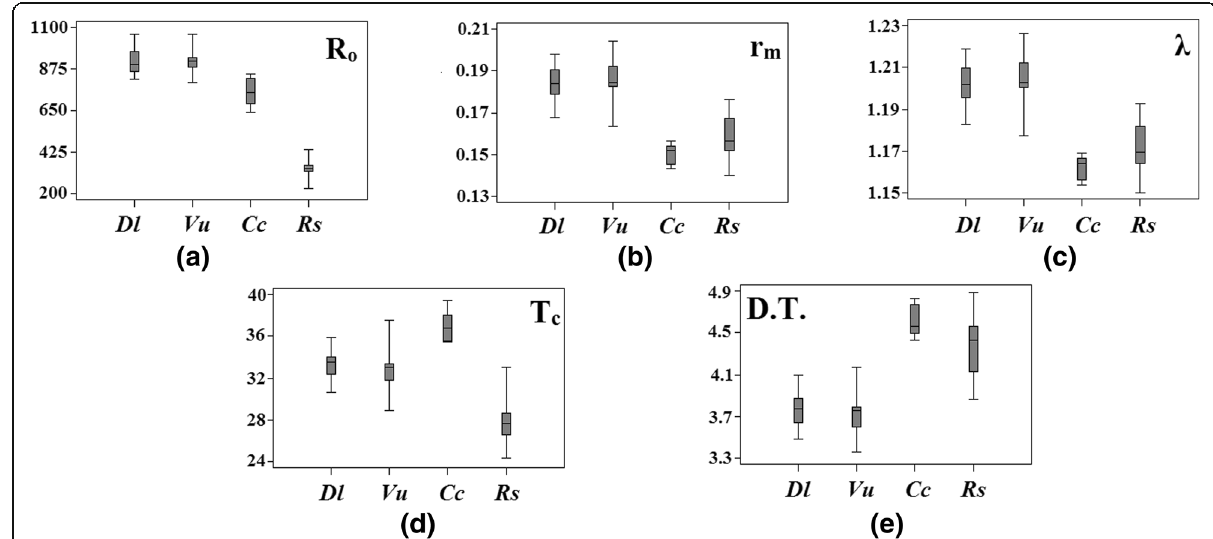
Fig. 2 a – e The box and whisker plots comprising of pseudo-values of the demographic parameters ( R o , r m , λ , T c , and D.T.) of H. variegata , when fed on A. craccivora reared on four host plants, viz. D. lablab (Dl), V. unguiculata (Vu), C. cajan (Cc), and R. sceleratus